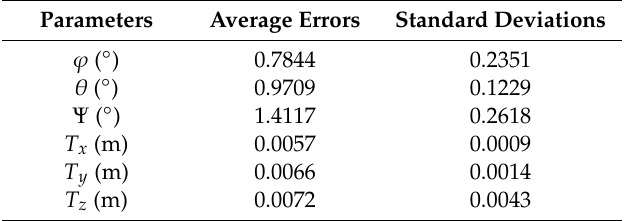
Table 6. Average errors and standard deviations of six-degrees-of-freedom (6-DOF) measurement of rigid